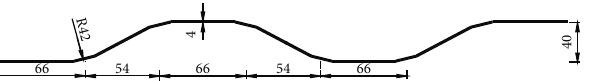
Figure 10. The finite element model of the composite box girders with CSWSB was established using the ANSYS software. The solid element named solid 45 was applied for the simulation of the upper flange plate of the composite box girder, and the shell element named shell 63 was employed to simulate corrugated steel web, steel bottom plate, lon- gitudinal rib, and diaphragm plate. In actual bridge struc- tures, the CSW and steel bottom plates were welded and concrete upper flange plates were connected using shear keys. In the developed model, the shell and the solid ele- ments shared the joint, and the master-slave node method was applied in order to establish the constraint equation connection. The finite element model of composite box girders with CSWSB with a single box and the single chamber is shown in Figure 11.